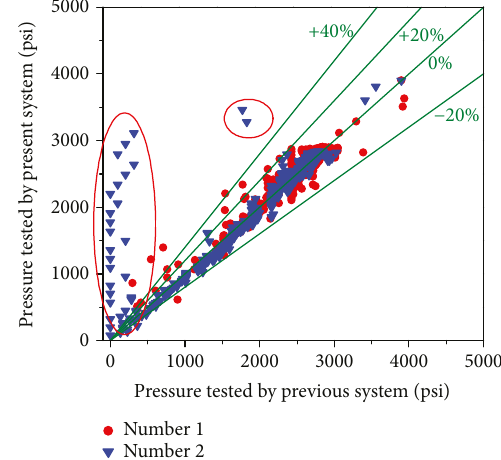
Figure 15: Cross-plot of two pressures for both the present and the previous